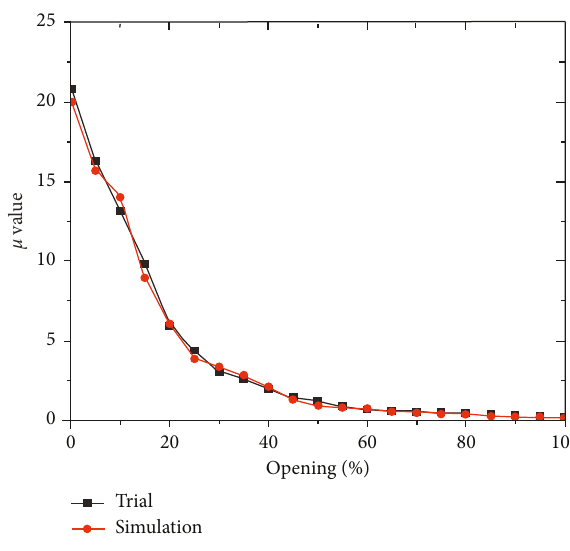
Figure 22: Resistance coefficient curve.